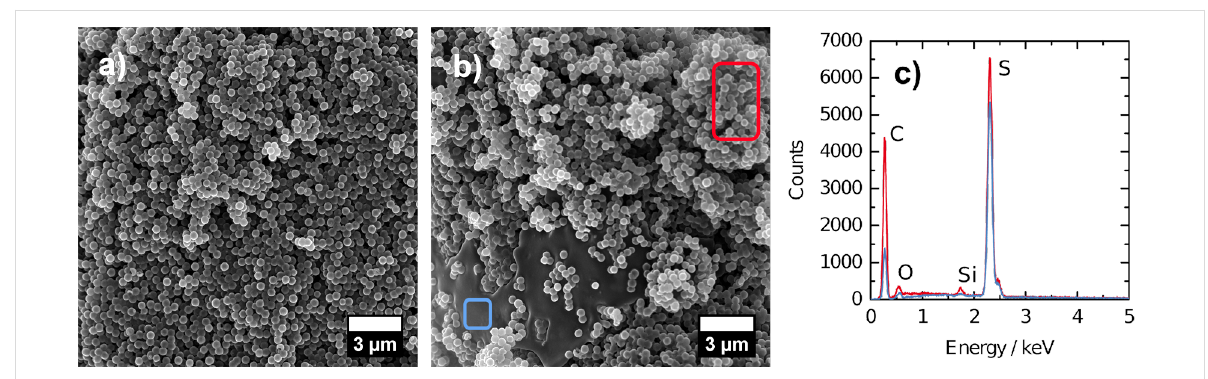
Figure 7: SEM images of a) HCS-58-vac, b) HCS-67-vac, and c) EDX spectra of HCS-67-vac (measured areas are marked red and blue, respective-